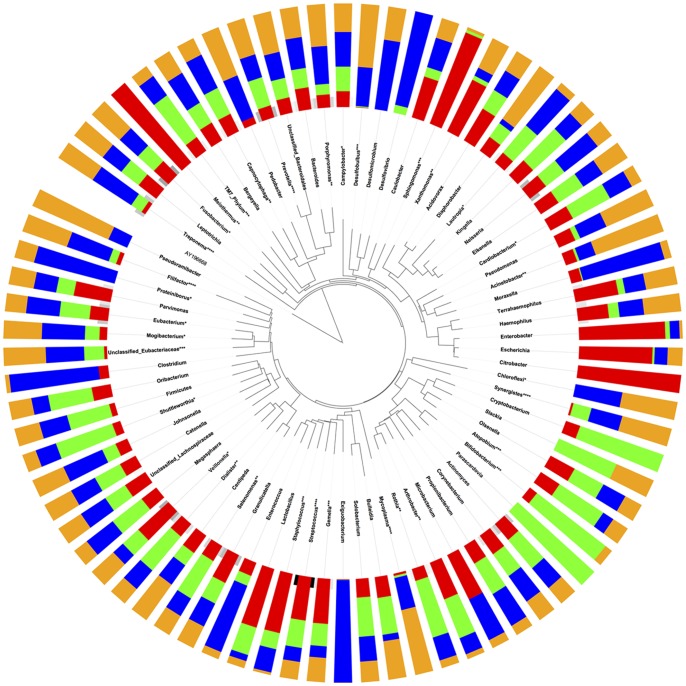
Relative abundances of 77 genus-level OTUs(g-OTUs).Figure was generated using ITOL. Non-Hispanic blacks are indicated by red, non-Hispanic whites are indicated by green, Chinese are indicated by blue, and Latinos are indicated by orange. The abundances of four s-OTUs and several g-OTUs were significantly different between ethnicities (*p<0.05, **p<0.01, ***p<0.001, ****p<0.0001, ANOVA on transformed variable).